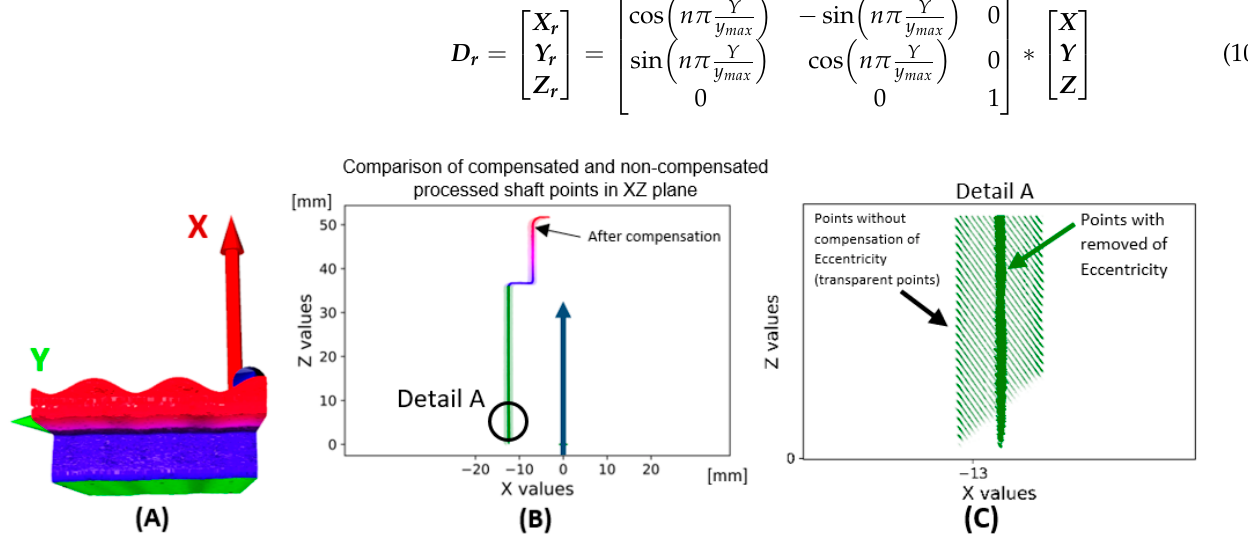
Figure 11. Data with suppressed eccentric: ( A )—3D; ( B )—projected point cloud to 2D, plane XZ; ( C )—detail to points with removed first harmonic component as eccentricity (dark green color) and points with eccentricity (transparent green points).